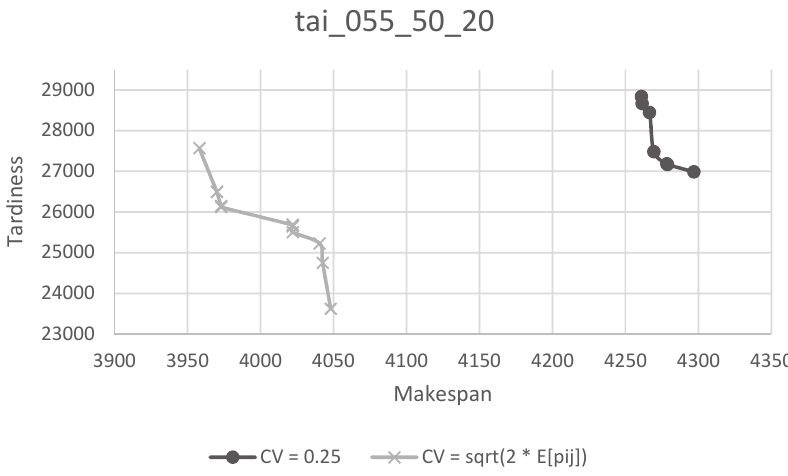
Fig. 9. Pareto fronts of Taillard’s instance 55 (50 jobs × 20